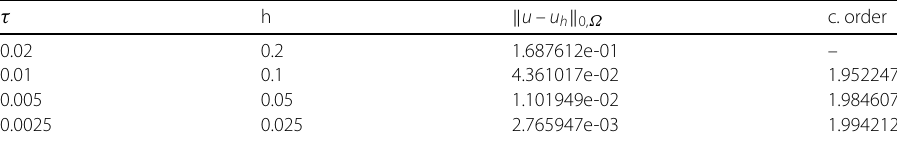
Table 1 The global errors and convergent orders at t = 1 for α = 1 with τ = 0.1 ∗ h